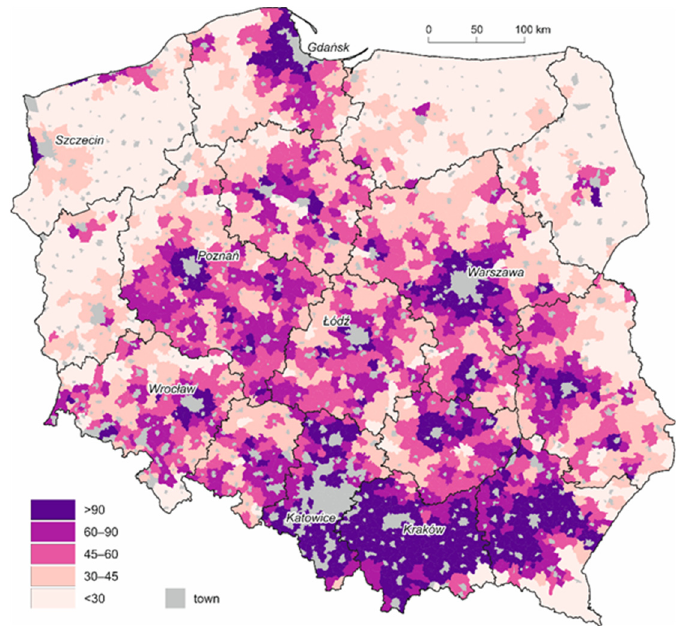
Figure 3. Rural population density (population/km 2 ) (2018). Source: Own study based on BDL GUS data.